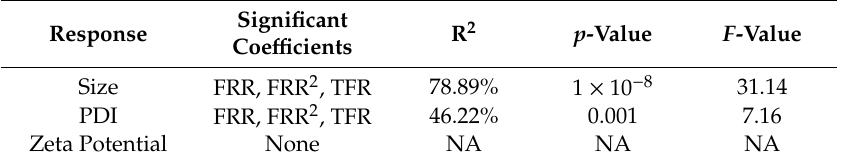
Table 4. Statistically significant coefficients for each model ( p < 0.05) and model statistics summary.